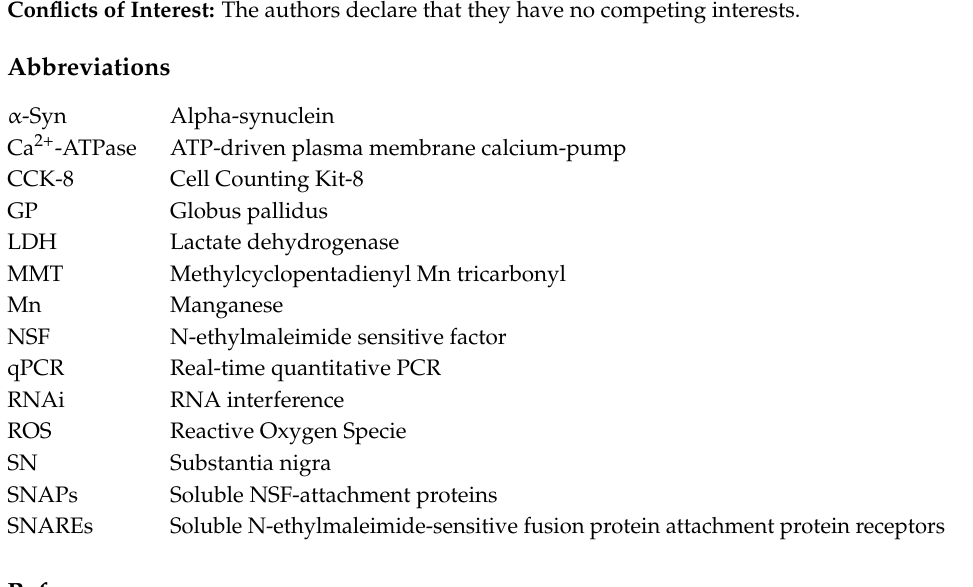
Figure S1: Mn induced cell injury in SH-SY5Y. Figure S2: Calpeptin could ameliorate Mn-induced cell injury and the over-activation of calpains. Figure S3: α -Syn shRNA reduced α -Syn expression level and ameliorated cell injury during Mn exposure. Figure S4: Co-localization fluorescence signals of VAMP-2 and α -Syn, VAMP-2 and synaptophysin in